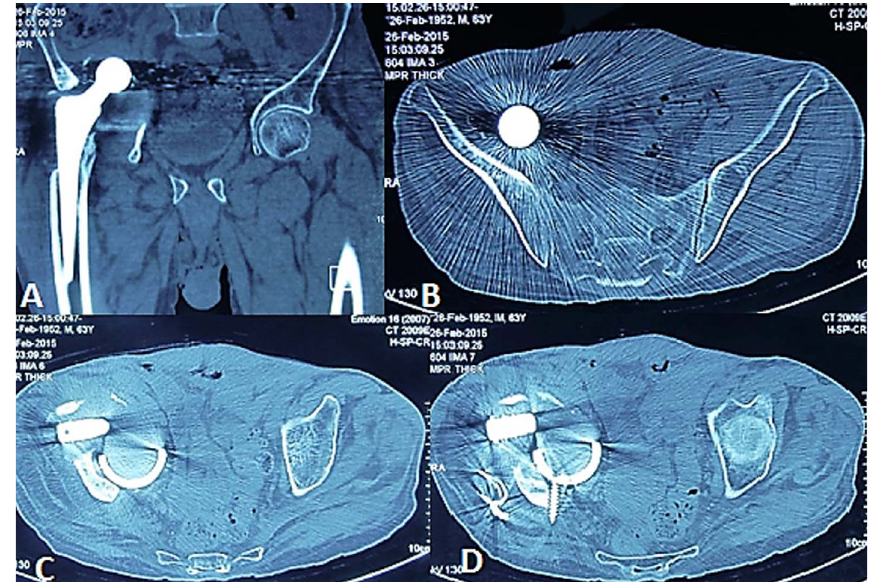
Figure 2. CT con fi rmed the intrapelvic protrusion of the cup, osteolytic defects, and the dome screw which is directed